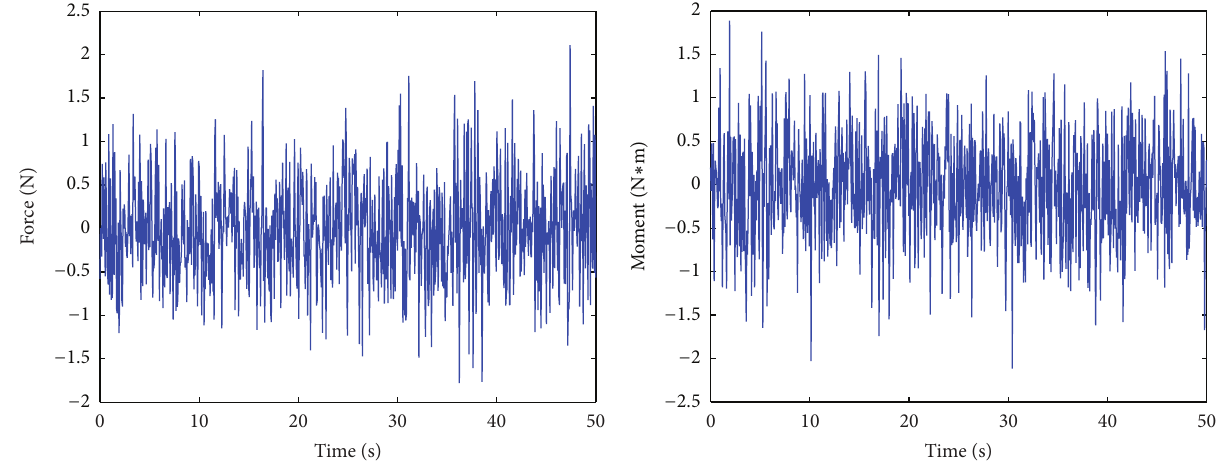
Figure 2: Wave force and wave